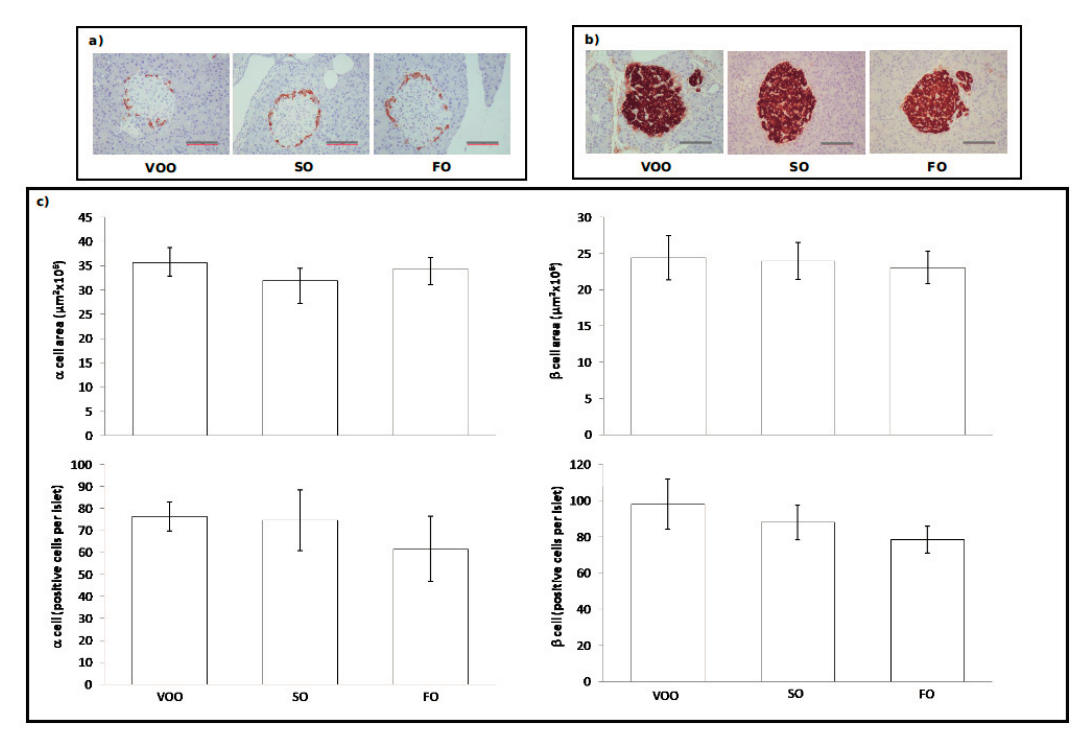
Figure 4. Immunohistochemical assessment in the pancreas of rats fed on different dietary fat sources supplemented with Coenzyme Q: virgin olive oil (VOO), sunflower oil (SO) and fish oil (FO). ( a ) Histological sections with pancreatic isles immunostained for glucagon from rats fed on VOO, SO and FO; ( b ) Histological sections with pancreatic isles immunostained for insulin from rats fed on VOO, SO and FO; ( c ) Quantitative data from histological evaluations of α - and β -cell positive density and area. Data are presented as mean ± SEM. Scare bar = 100 μ